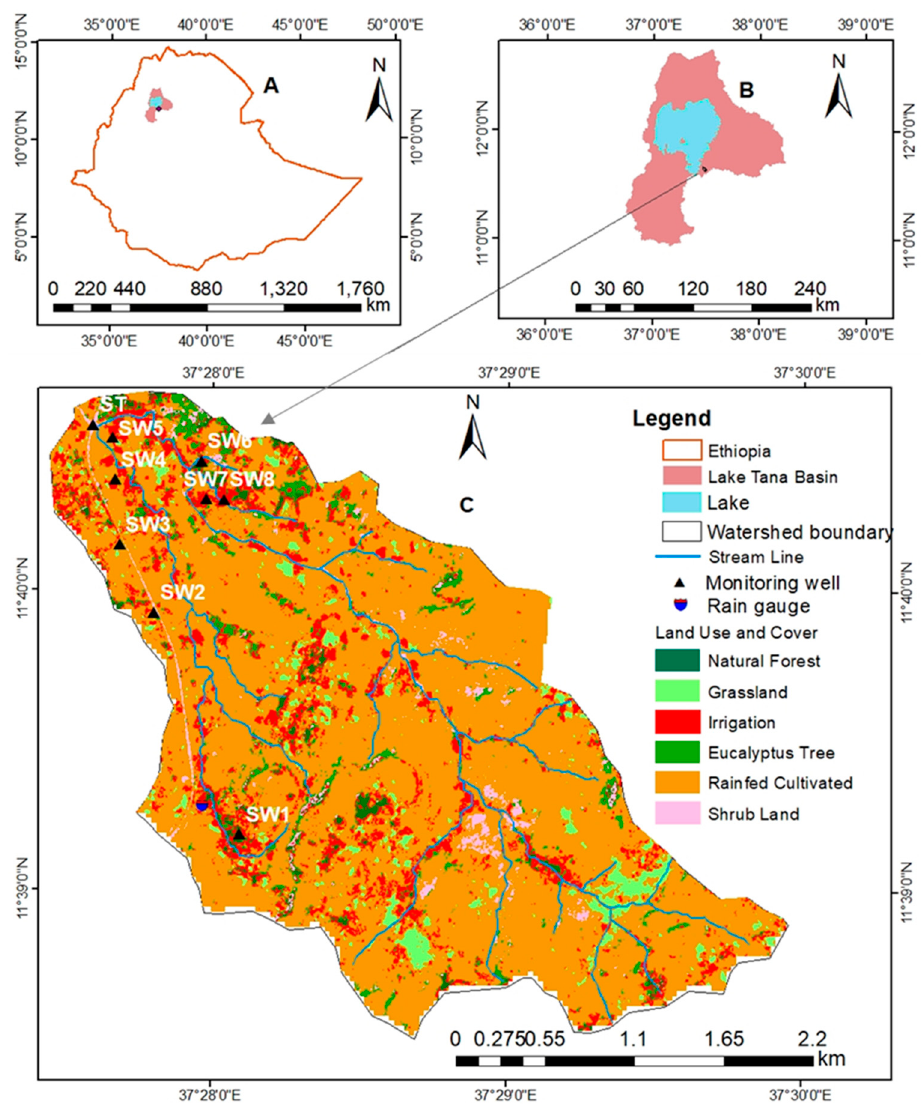
Figure 1. Location of Robit Bata watersheds in Lake Tana basin. ( A ) Lake Tana basin, ( B ) location of Robit Bata within Lake Tana basin, and ( C ) land use and cover maps, with monitoring wells in Robit Bata watersheds. SW1-SW8 are the sampling well identifiers, and ST is the outlet. The upper part of the watershed is severely degraded with shallow Eutric Cambisols and Luvisols soils over bedrock; the middle and lower portions of the watershed are Ali- sols up to 15 m in depth [41]. These soils have a clay loam texture with an average organic carbon content of 1.6 mg L − ¹ [41,42]. They are underlain in the lower portion by the regolith layer. Water loss from the upper part is mainly caused by saturated excess overland flow. In the middle and lower part, rainwater infiltrates and recharges a hillslope aquifer. The aquifer forms at the beginning of the rain phase in June and lasts about three months after the rain ends (December) due to the high base flow draining the aquifer. The hillslope aquifer drains fast due to the high transmissivity of 700 m² day − ¹ [43] and 5–8% slopes.